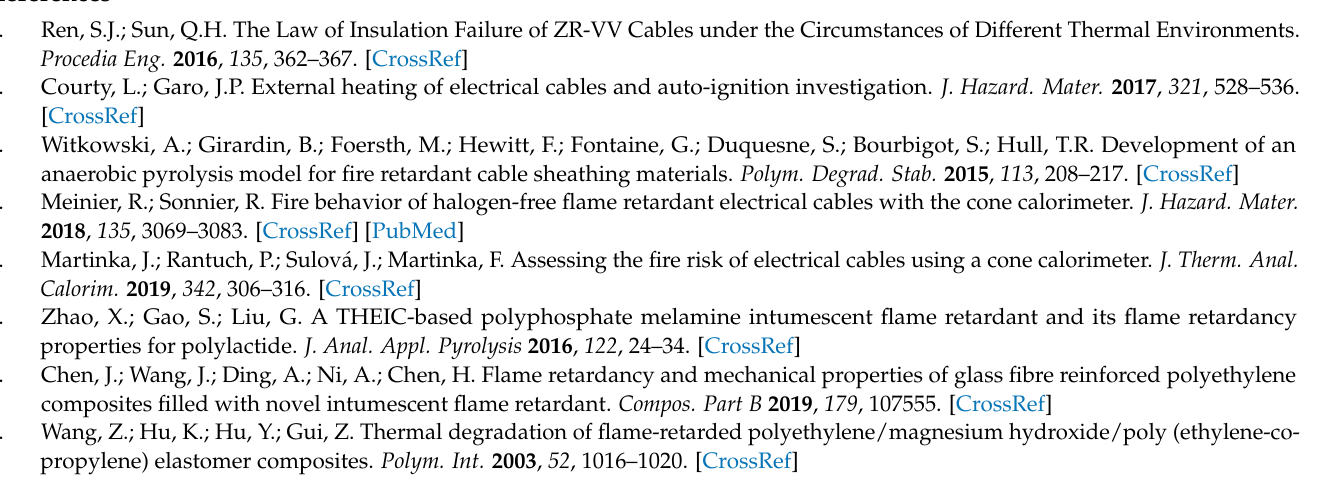
Figure S2: Mechanical properties of EVA/CLNA-8400/EBM/120phr flame retardants (MH) formu- lations as a function of EXACT 8201 content; Table S1: EVA/EBM/CLNA-8400/120 phr MH flame retardant formulations as a function of Tafmer 805 content; Table S2: EVA/120 phr MH formulations as a function of EBM